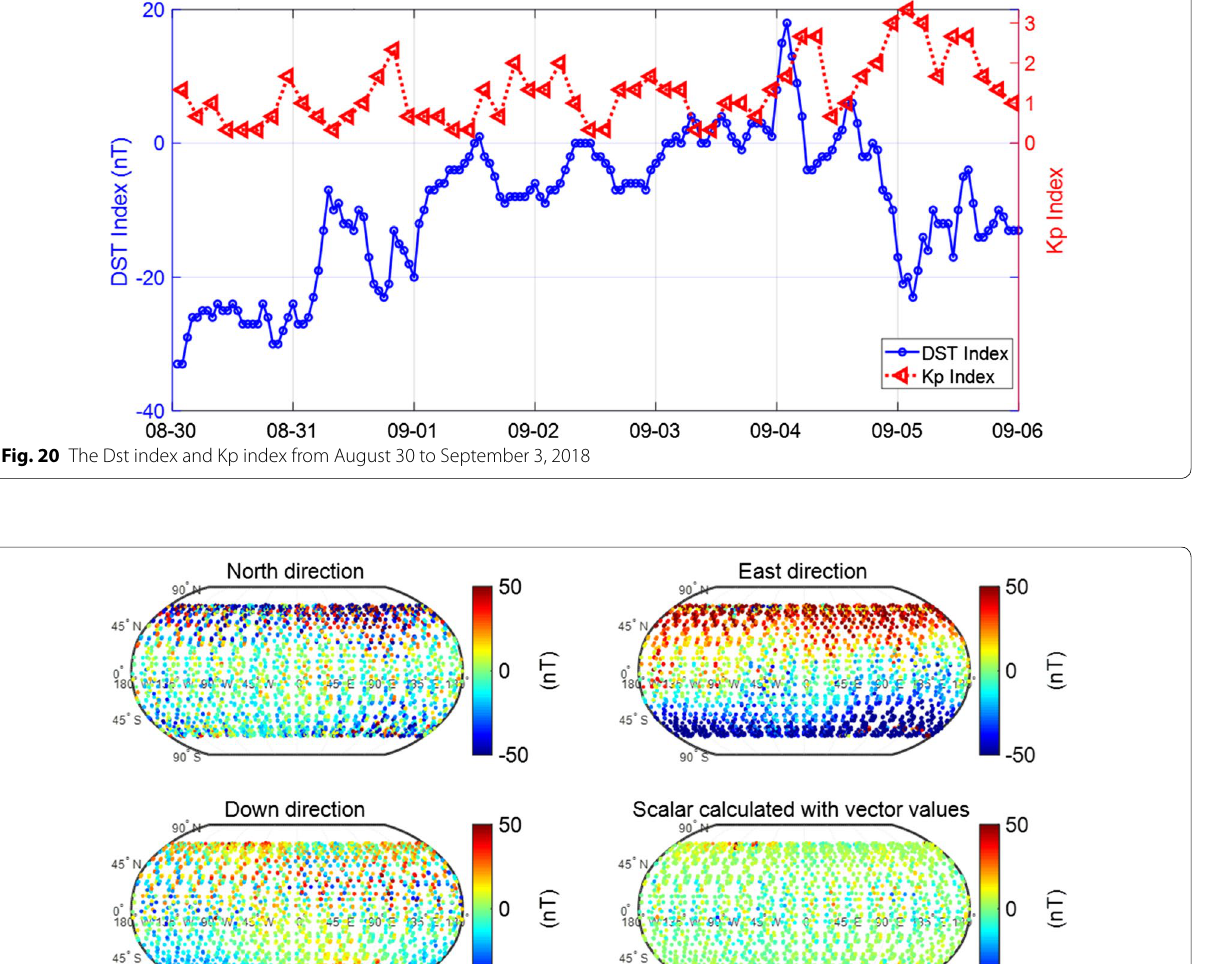
Table 3 Statistics of CSES and SWARM A, B, and C satellite data from August 30 to September 3, 2018 Component CSES vs. SWARM A CSES vs. SWARM B CSES vs. SWARM-C Mean (nT) Variance